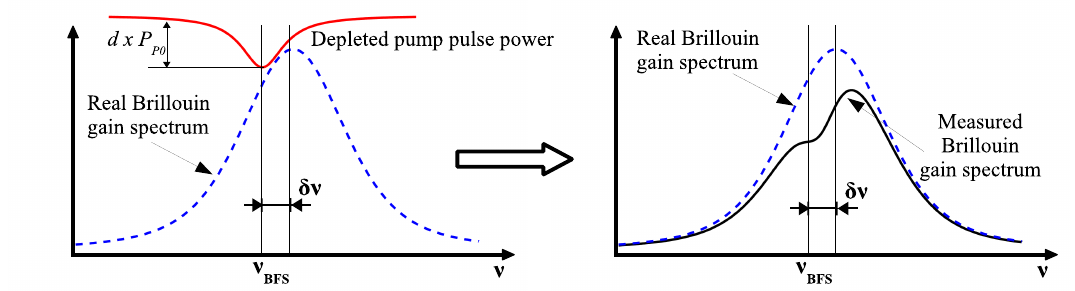
Figure 1. Effect of pump pulse depletion frequency dependence on a Brillouin gain spectrum, when scanning a fiber section displaced δν MHz from the Brillouin frequency shift (BFS) of the